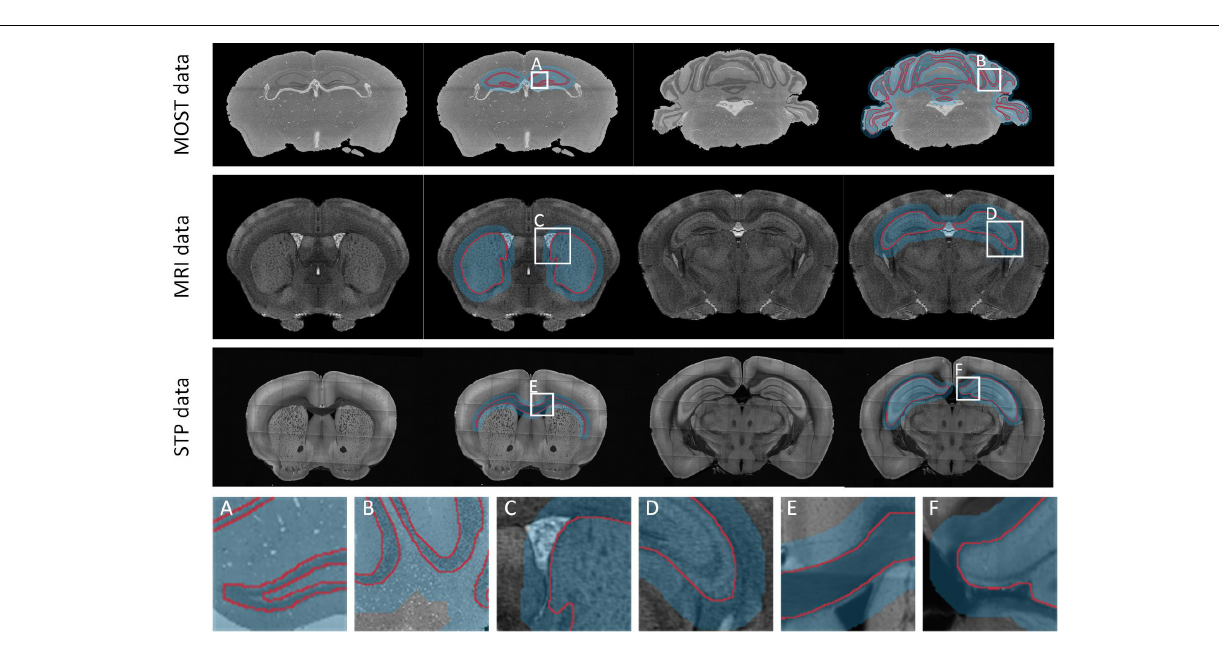
representative structure with which to compare segmentation effects. The input images for DeepBrainSeg, U-net, V-net, and Segnet were full resolution of around 600 × 1000 pixels 2 , while for FC-DensNet, they are limited to 400 × 600 pixels 2 due to the memory capacity of a GPU. Figure 9 shows the results of these methods from top to bottom. The green